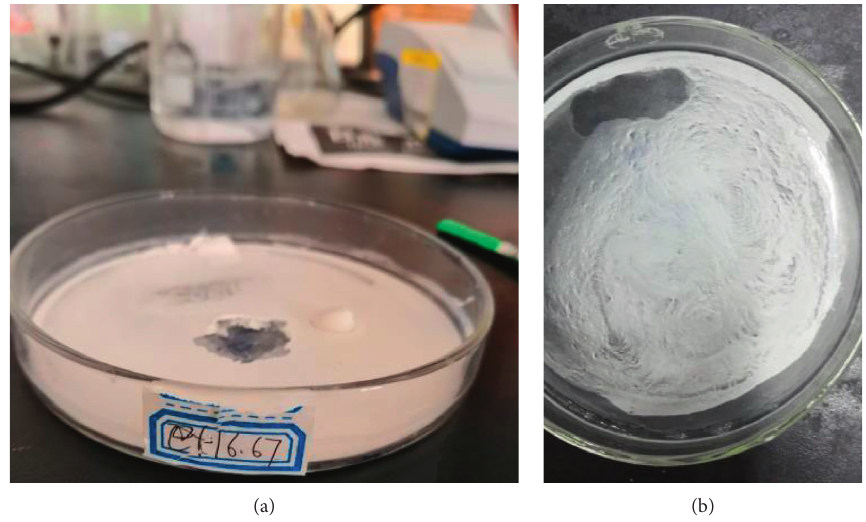
Figure 6: Comparison of the amount of calcium carbonate with (a) and without (b) Bacillus mucilaginosus